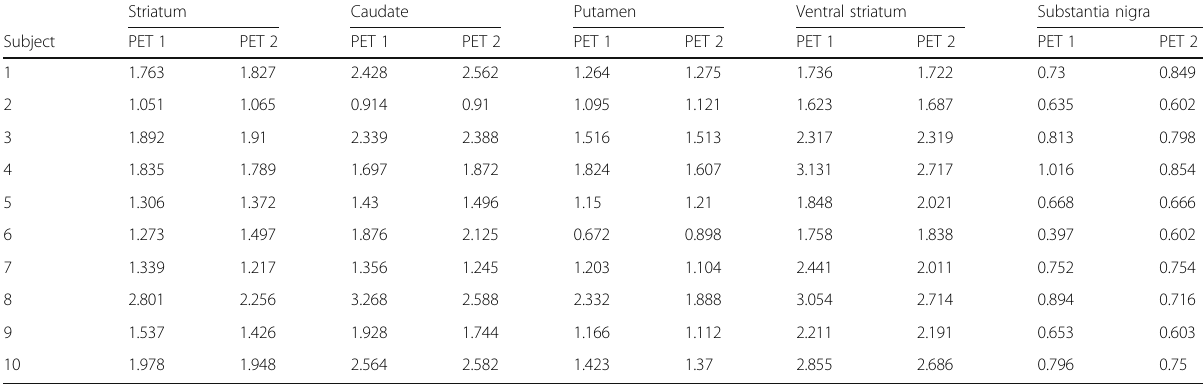
Table 2 Individual binding potential ( BP ND ) values of [ 18 F]FE-PE2I in striatal regions and substantia nigra Striatum Caudate Putamen Ventral striatum Substantia